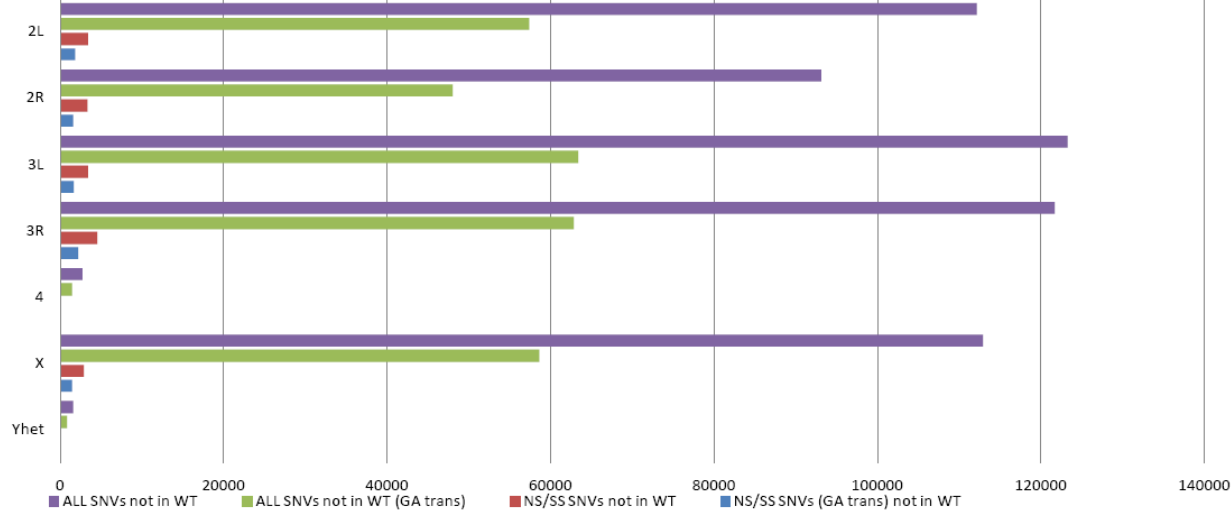
Figure 1. Distribution of detected SNVs not present in background on each chromosome. Purple bars represent the total number of SNVs that were observed in mutant genomes but not in the background genome. Green bars represent the number of SNVs that were G>A or C>T transitions. Red bars represent the number of nonsynonymous or splice-site SNVs that were not present in the wild-type genome and detected in the mutant genomes. Blue bars represent the number of nonsynonymous and splice-site SNVs that were G>A or C>T